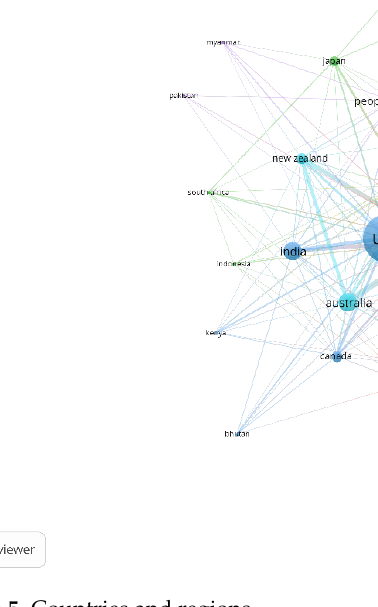
Figure 5. Countries and regions.